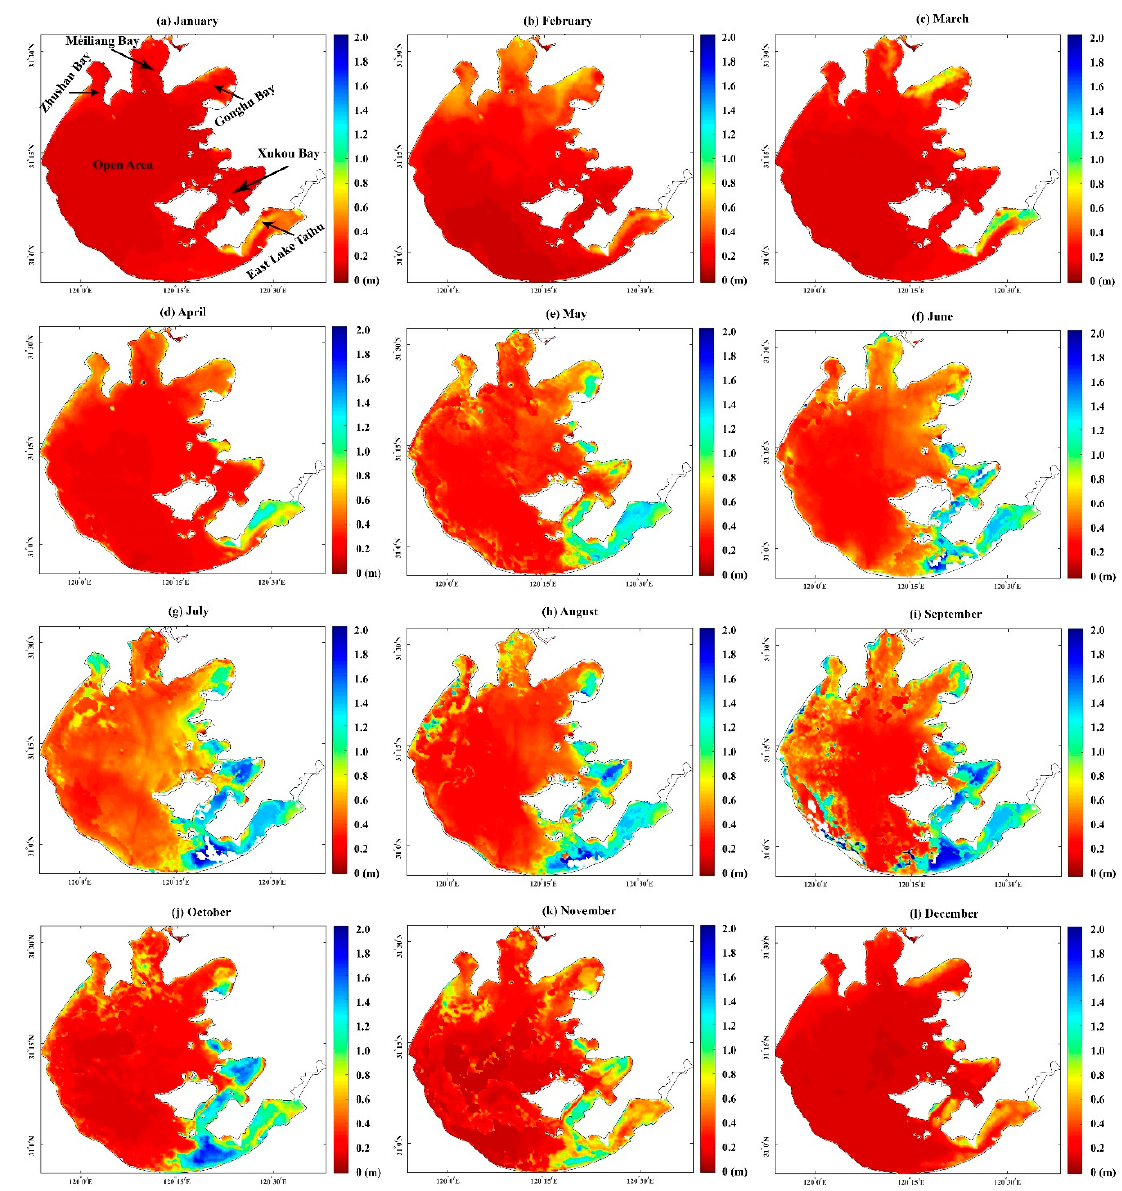
Figure 11. Phenological distribution of Z SD in Lake Taihu, calculated from all valid pixels of the 74 selected MERIS images using QAA TI .